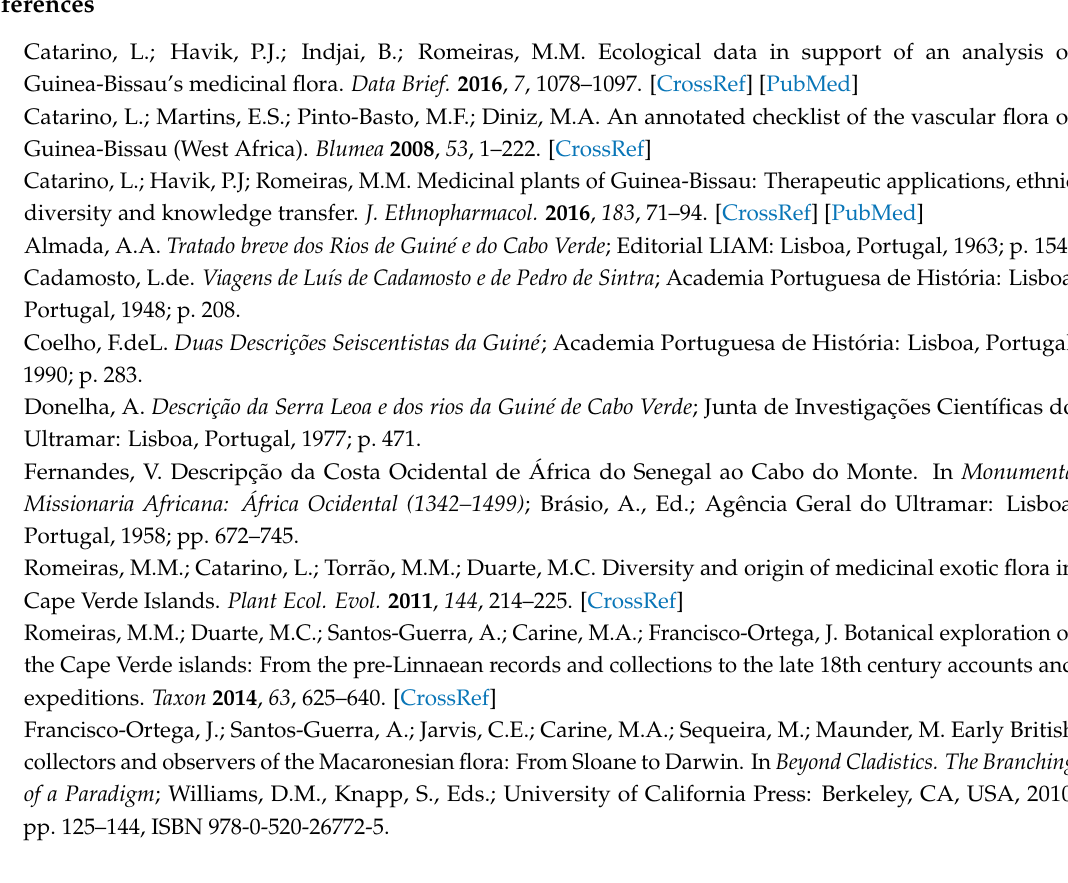
Figure S1: Isotype of Ctenium serpentinum Steud “île de Miel”, Jardin 124 B, P (Mus é um National d’Histoire Naturelle, Paris (France), Collection: Vascular plants (P), Specimen P00439449), Supplementary Table S1: É d é lestan Jardin: the first list of plants collected in Bijag ó s Islands (1845-48), Supplementary Table S2: Historical data on the principal botanical explorations of Guinea-Bissau flora (18th-early-20th centuries) with reference to collectors that are referred as has travelling through